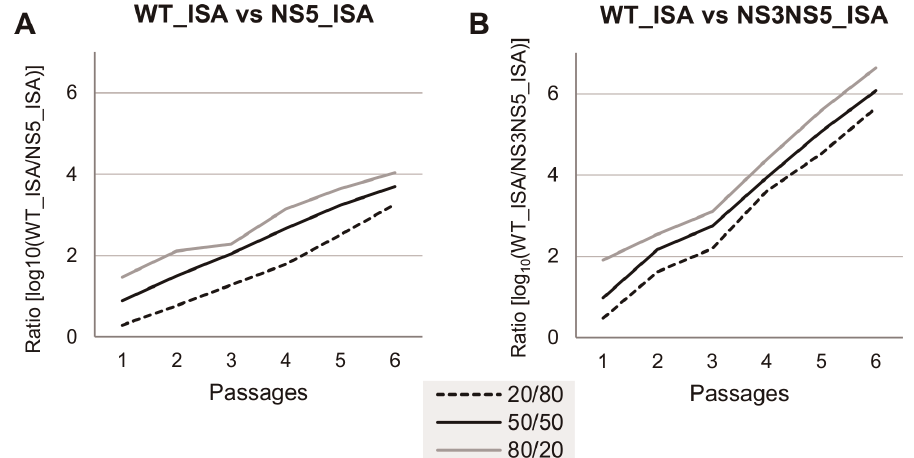
Fig 1. In cellulo replicative fitness in BHK21 cells. Results of competition experiments performed using three initial TCID50 ratios (wild-type/re-encoded: 20/80, 50/50, 80/20). Two qRT-PCR assays, each specifically detecting one of the competing virus, enabled to monitor the evolution of the proportion of each virus along 6